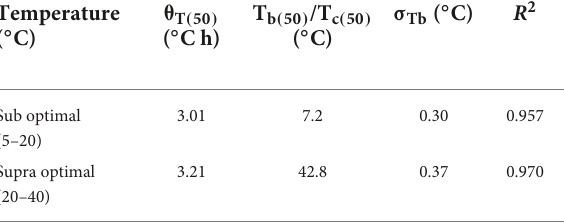
Frontiers in Plant Science